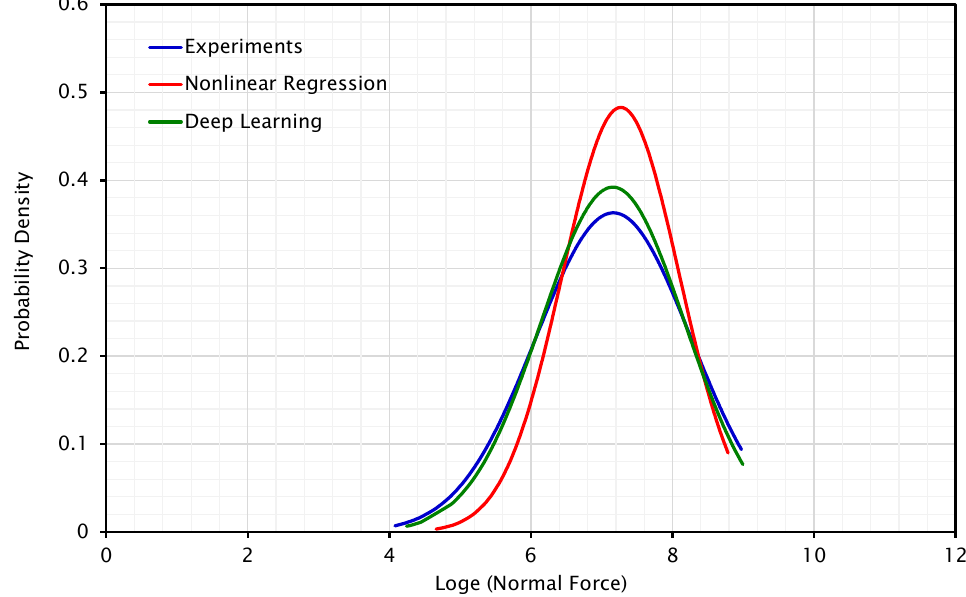
Figure 13. Normal distribution of normal force concluded from experimental data and the results of regression by non-linear regression and deep learning